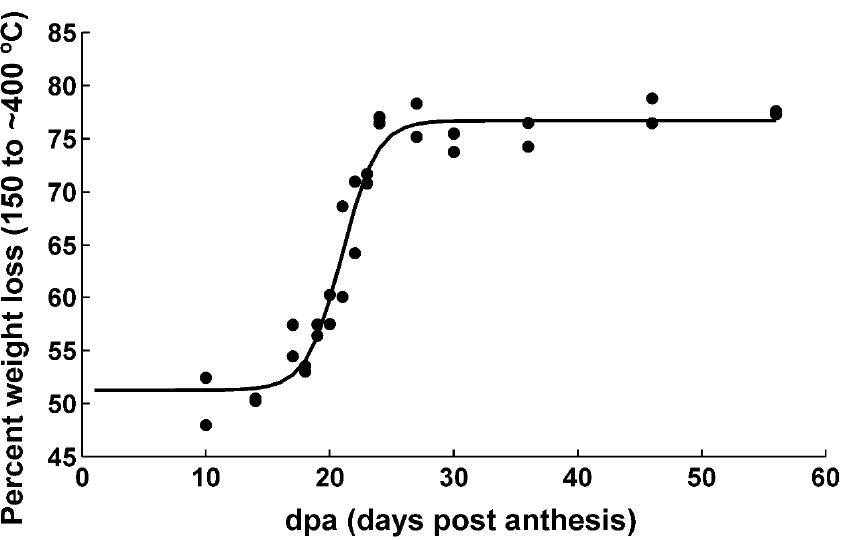
Figure 9. Evolution of the weight loss percent in the region from 150 to ~400 °C as a function of dpa for TM-1 genotype.